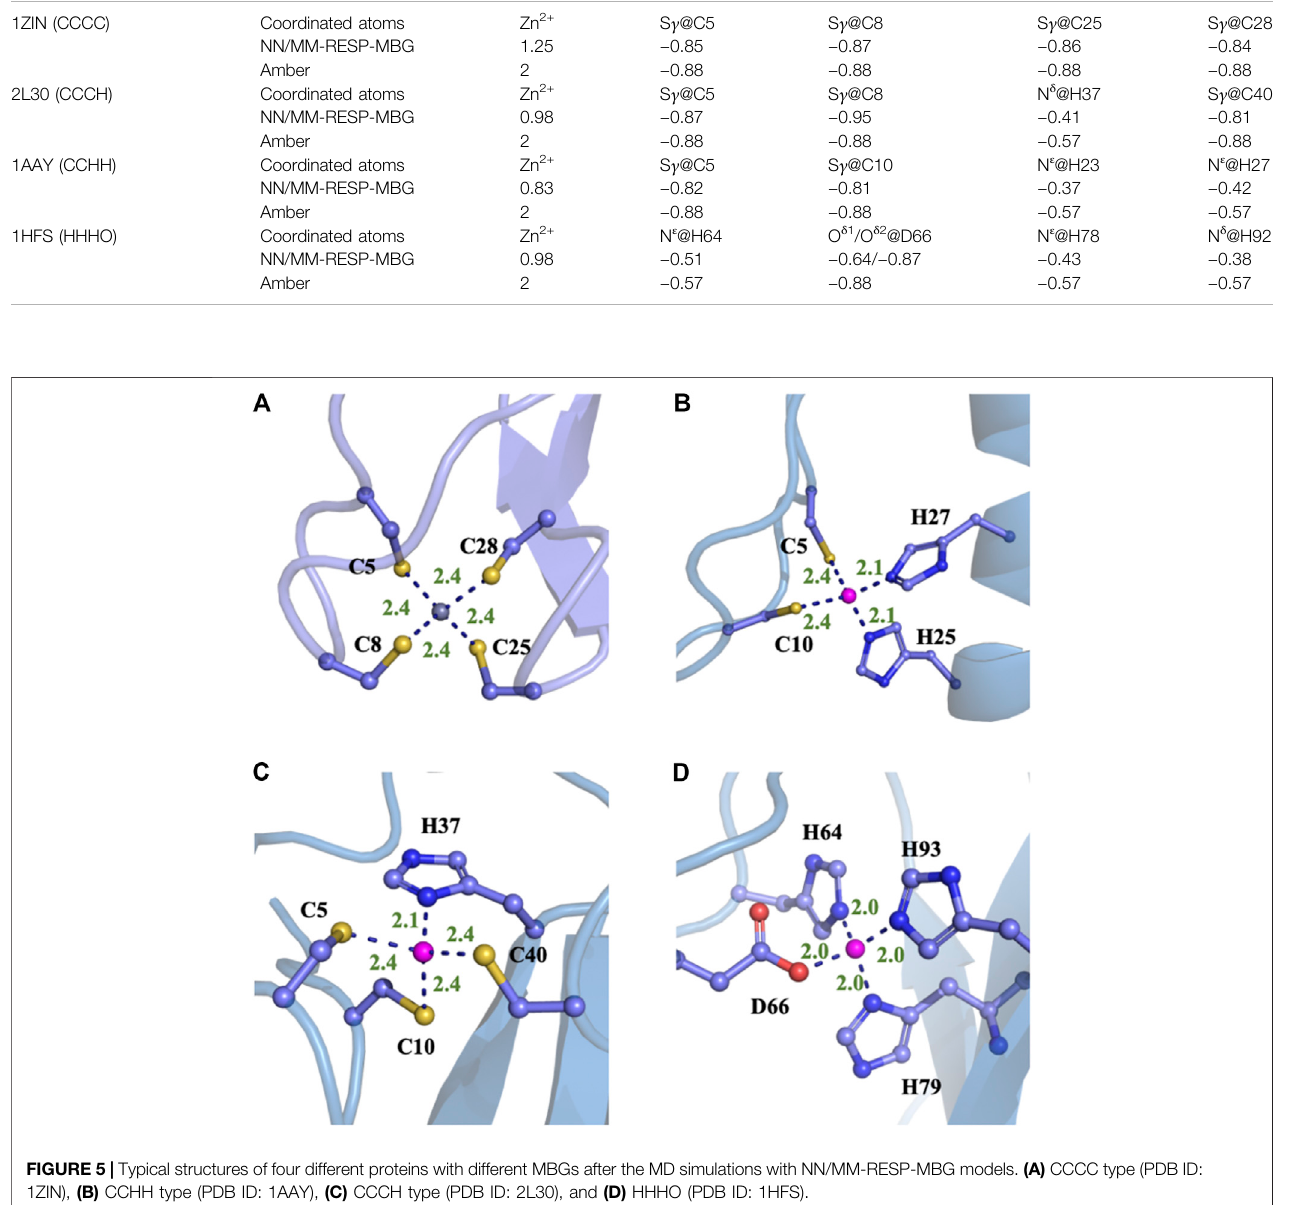
Frontiers in Chemistry |